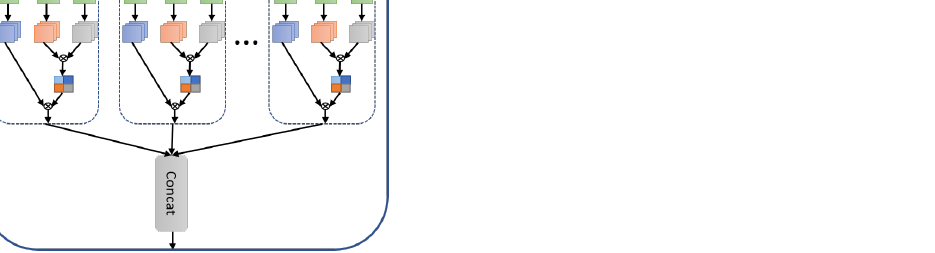
Figure 3. Multi-headed Self-Attention: The self-attention is applied to the same features and then concatenated.